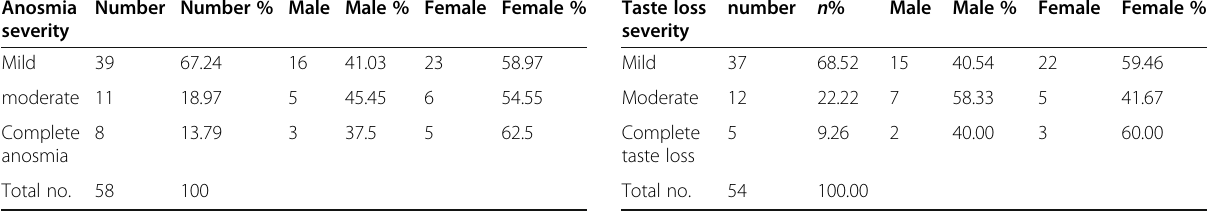
Table 1 Anosmia severity gender distribution Anosmia severity